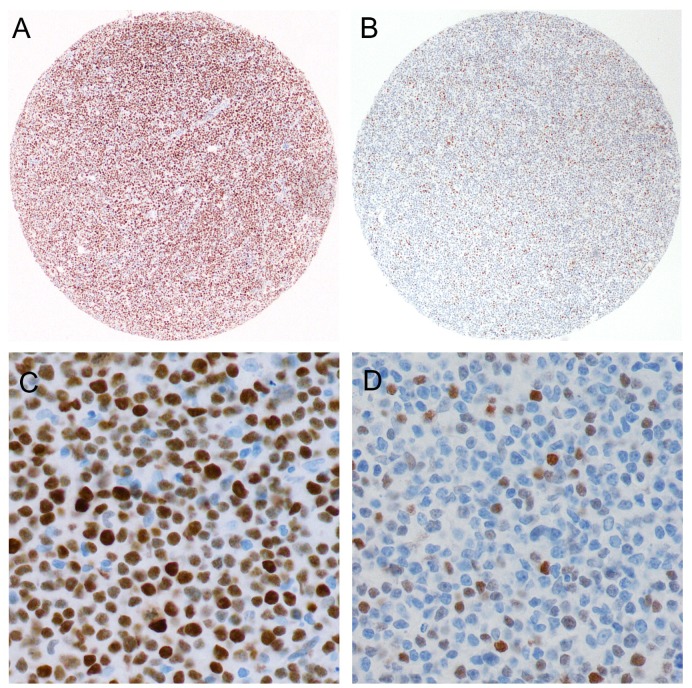
Tissue microarray based representative immunohistochemical analysis of MYC protein expression in DLBCL.The MYC staining pattern is distinctly nuclear. (A, C) DLBCL scored as having ≥40% MYC-positive lymphoma cells. (B, D) DLBCL scored as having <40% MYC-positive lymphoma cells. A and B original magnification, ×40. C and D original magnification, ×400.